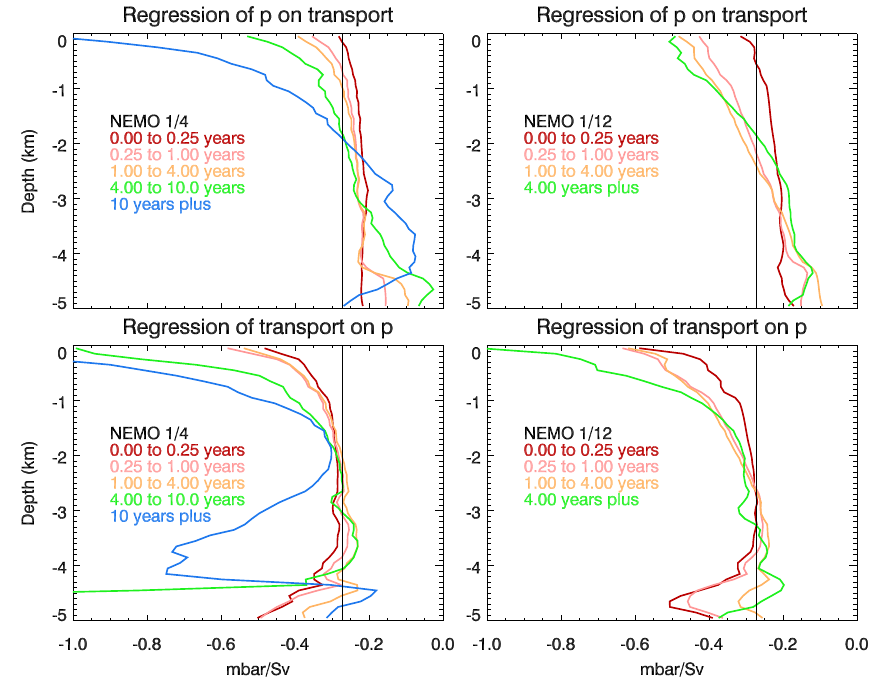
Fig. 5. Ratio of pressure p over transport ψ derived from linear regression of one on the other after applying various bandpass filters given in the legends. Upper panels show a from the regression p = aψ + b + noise, and lower panels show 1 /A from the regression ψ = Ap + B + noise. When both time series contain noise, the true relationship tends to lie between these two estimates. Left-hand panels are for the 1 / 4 ◦ model and right-hand panels for the 1 / 12 ◦ model. The black line shows the kinematic estimate for the depth-averaged coefficient: ( − 3.69Sv mbar − 1 ) − 1 .